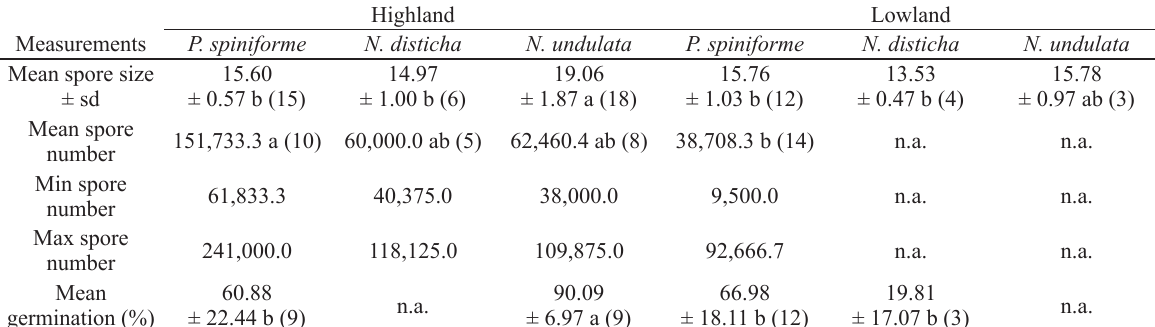
Mean ± standard deviation of spore size, number per capsule, and germination, as well as minimum and maximum values of spore number in the tropical mosses Pyrrhobryum spiniforme , Neckeropsis undulata and N. disticha in Brazilian Atlantic forest sites. Different letters indicate significant differences by multiple comparisons of mean ranks. Numbers in parentheses are number of capsules used in each analysis (N).